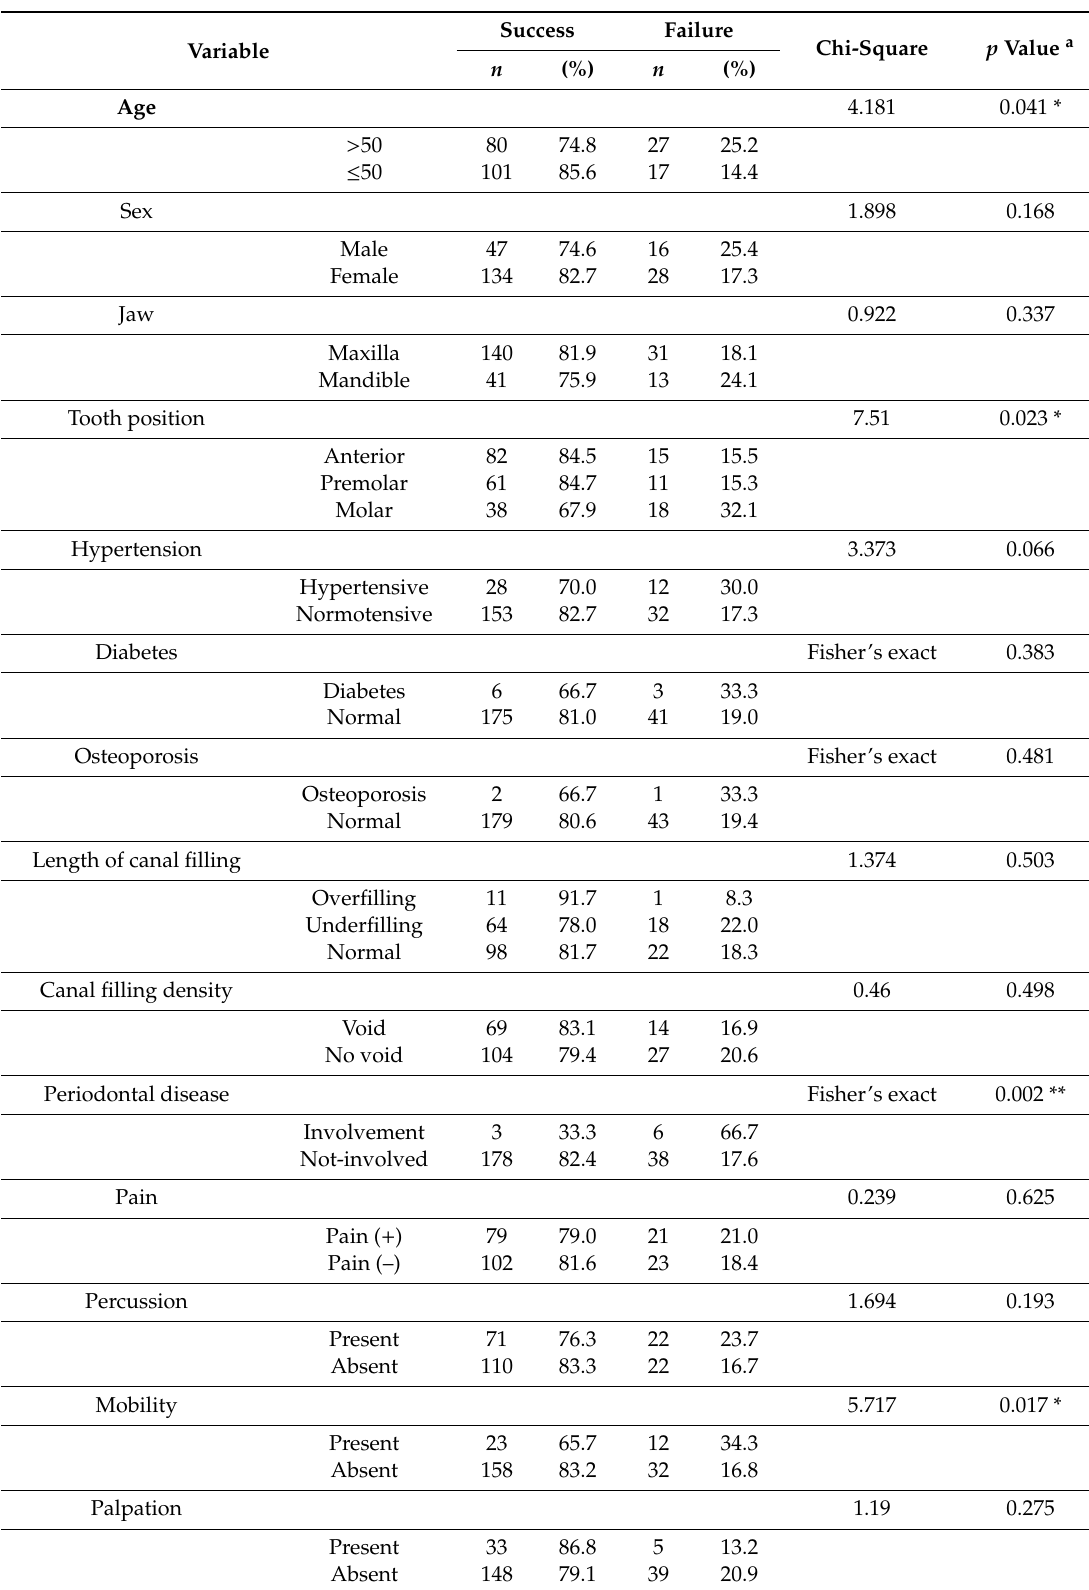
Table 2. Success rates analyzed (chi-square or Fisher’s exact test) for potential prognostic